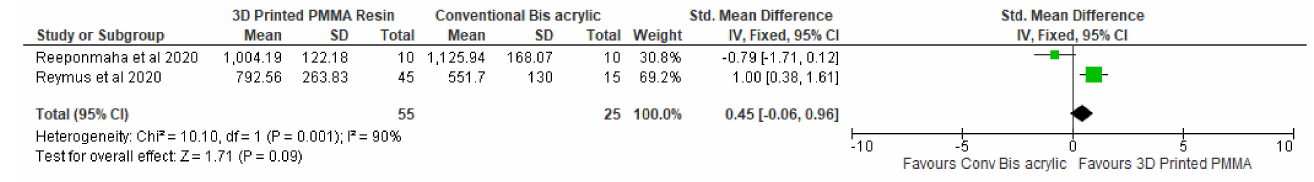
Figure 7. Forest plot comparing fracture strength between 3D-printed PMMA resin and conventional bBis-acrylic